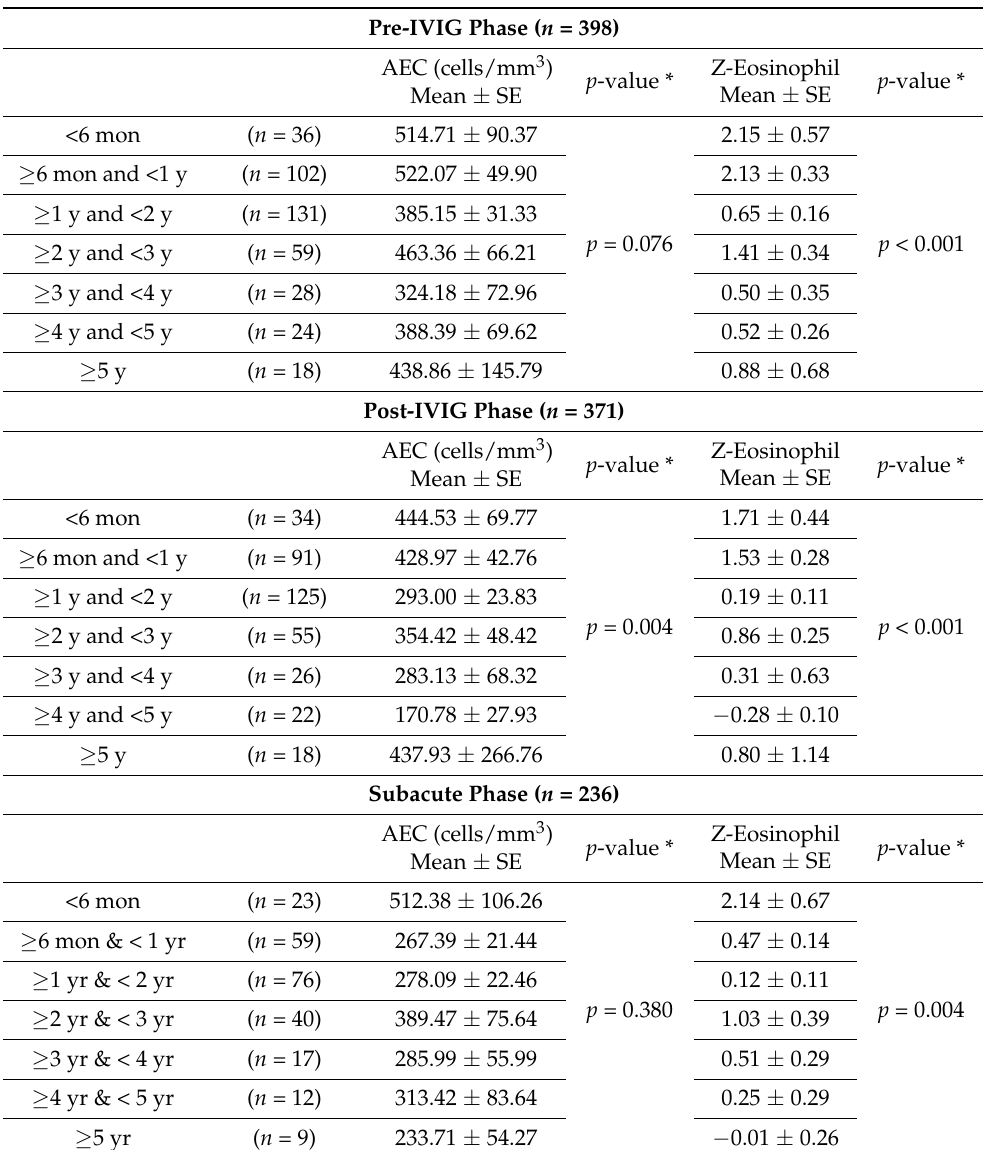
Table 1. The differences of absolute eosinophil count and Z-eosinophil among age subgroups according to Kawasaki disease patients.